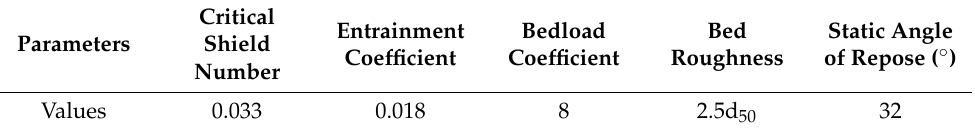
Figure 2. The layout of the computational domain (side view). Table 1. Parameters of the model.